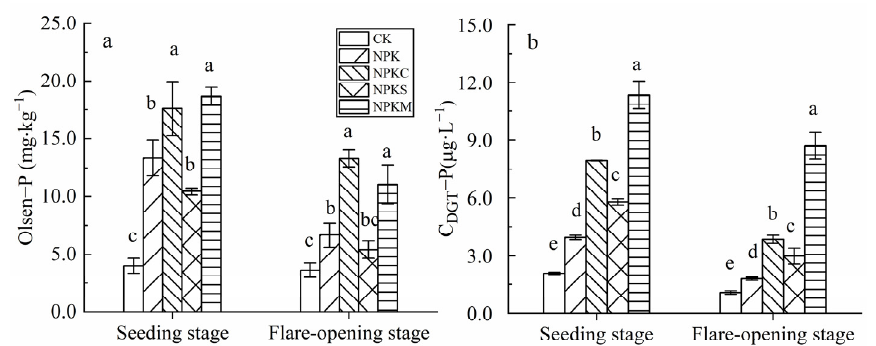
7 of 16 Figure 2. E ff ects of fi ve years of fertilizer application on plant P accumulation ( a ) and plant P content